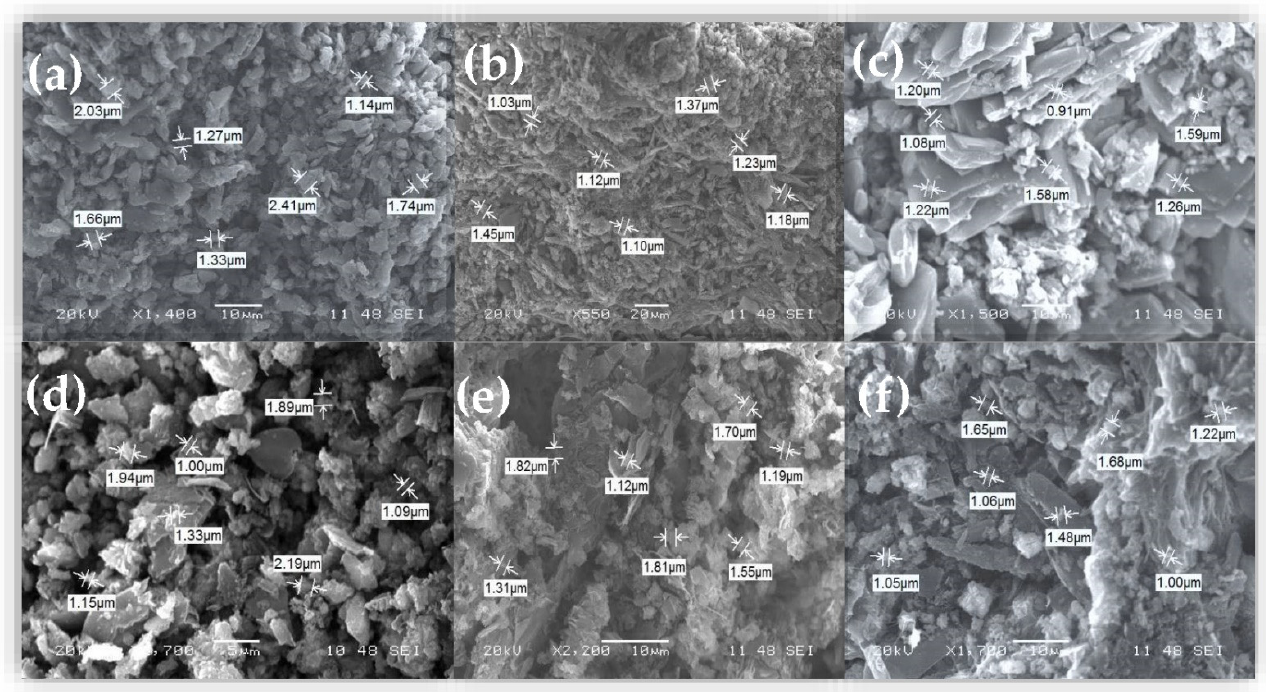
Figure 2. ( a – f ). SEM images of pure g-C 3 N 4 and its WO 3 /g-C 3 N 4 nanocomposite organic